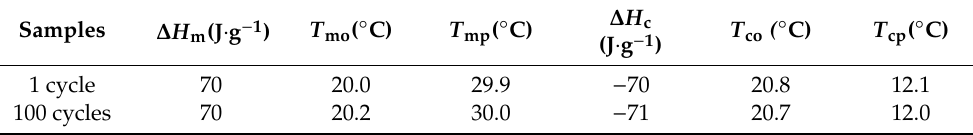
Figure 8. ( a ) Differential scanning calorimetry (DSC) curves and ( b ) FTIR spectra of SPCM10 before and after the various thermal cycling treatments. Table 2. DSC data of SPCM10 before and after thermal cycling treatments.